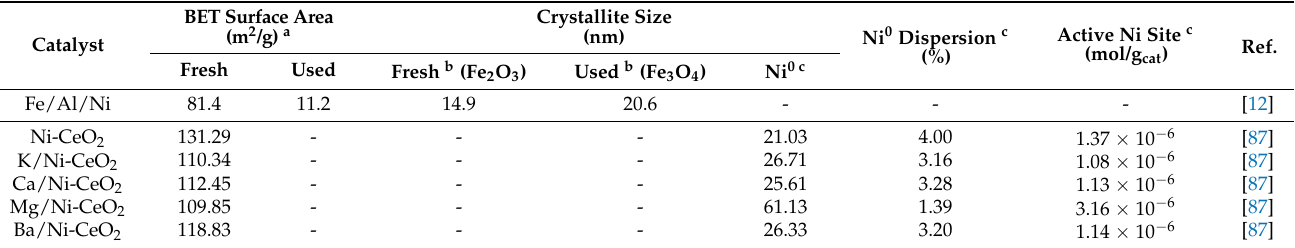
Table 7. Characteristics of Ni-based catalysts.